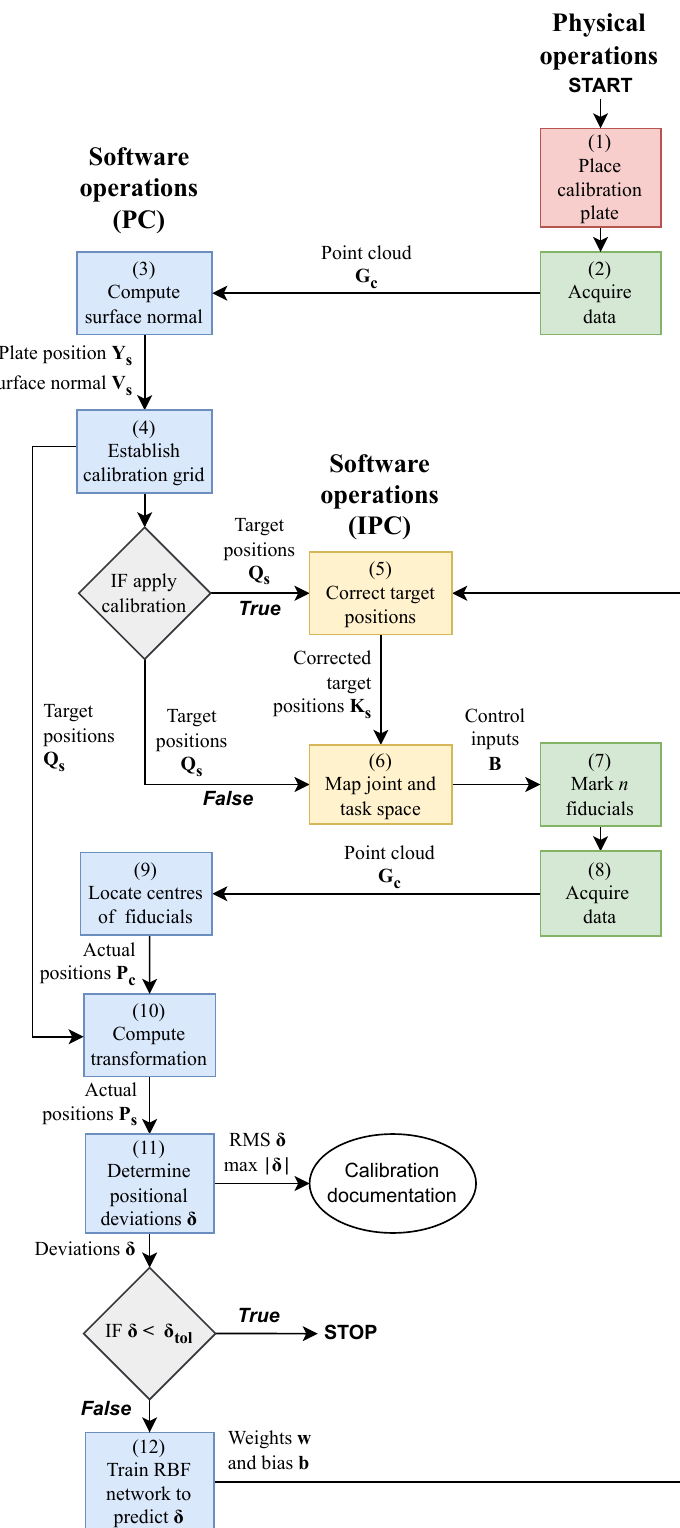
Figure 1. Flowchart providing an overview of the software and physical operations in the calibration methodology. The blue boxes indicate a software operation performed on the PC that handles the heavier computations. The yellow boxes indicate a software operation performed directly on the IPC controlling the GLS system. The red and green boxes represent manual and automatic physical